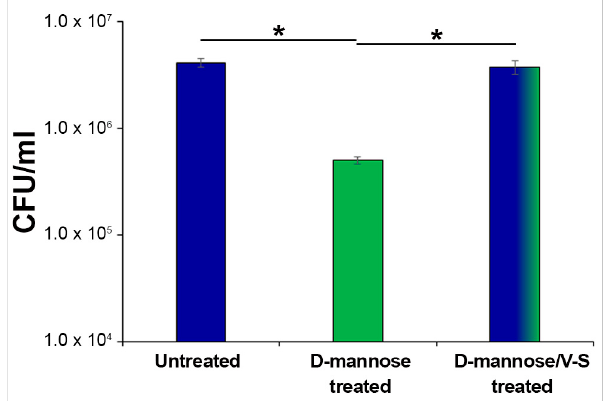
Figure 5. Bacterial adherence to bladder epithelial HTB-9 cells. Strain CFT073 was sub-cultured extensively with 1.5% d -mannose; one aliquot was vortexed and sonicated to break FimH– d -mannose bonds (referred to as V-S bacteria). Thus, E. coli suspensions of untreated, d -mannose-treated, and d -mannose-treated V-S were used to infect HTB-9 cell monolayers, at a multiplicity of infection (MOI) of 10. The total number of adherent bacteria was determined after 2 h of incubation with HTB-9 cell monolayers and expressed as CFU / mL. Data represent the mean of three independent experiments performed in triplicate. Asterisks indicate p values evaluated by one-way ANOVA; * p ≤ 0.05.